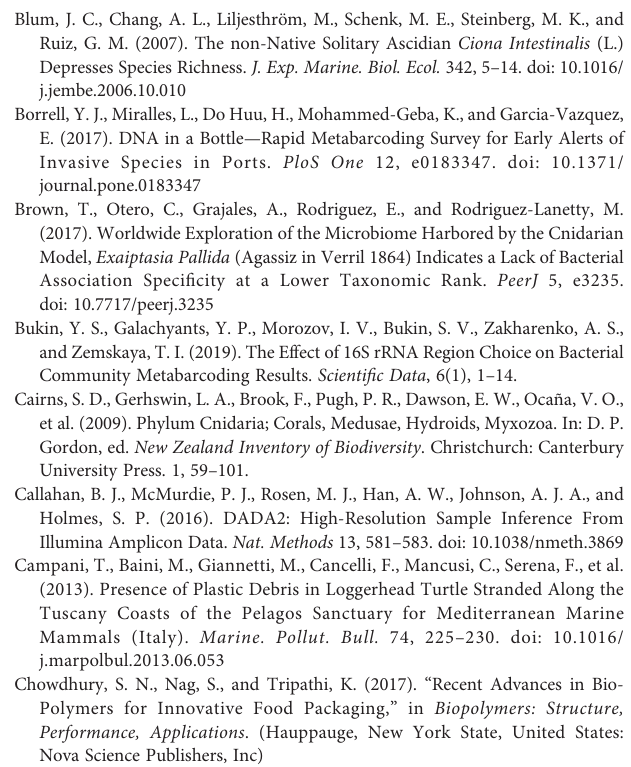
external to the tree represent the different substrates (Control, OYS20%, OYS40%,